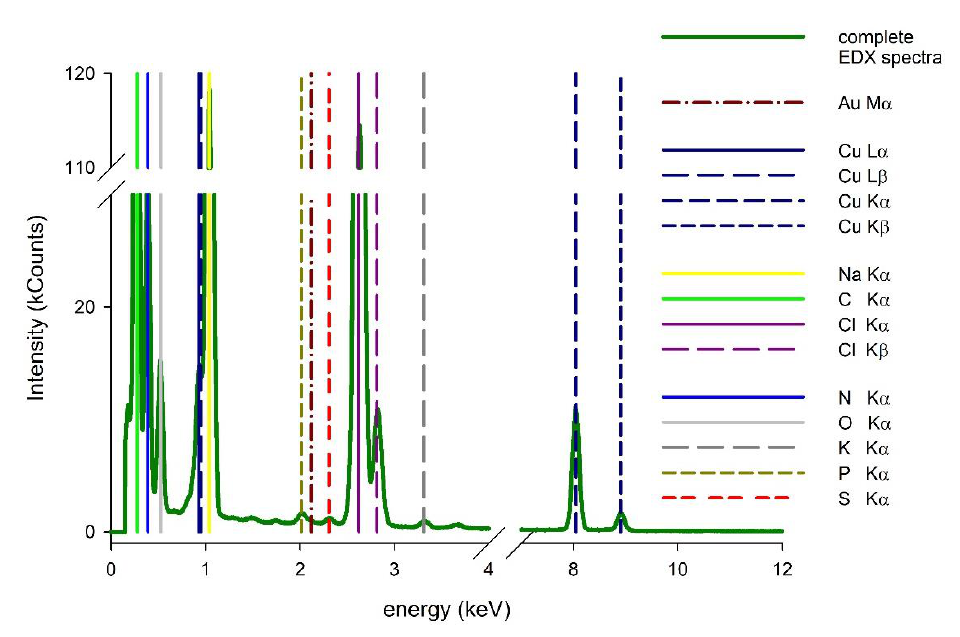
Figure 3. EDX spectra of PEI-Au-HAP membrane with Au peaks visible.